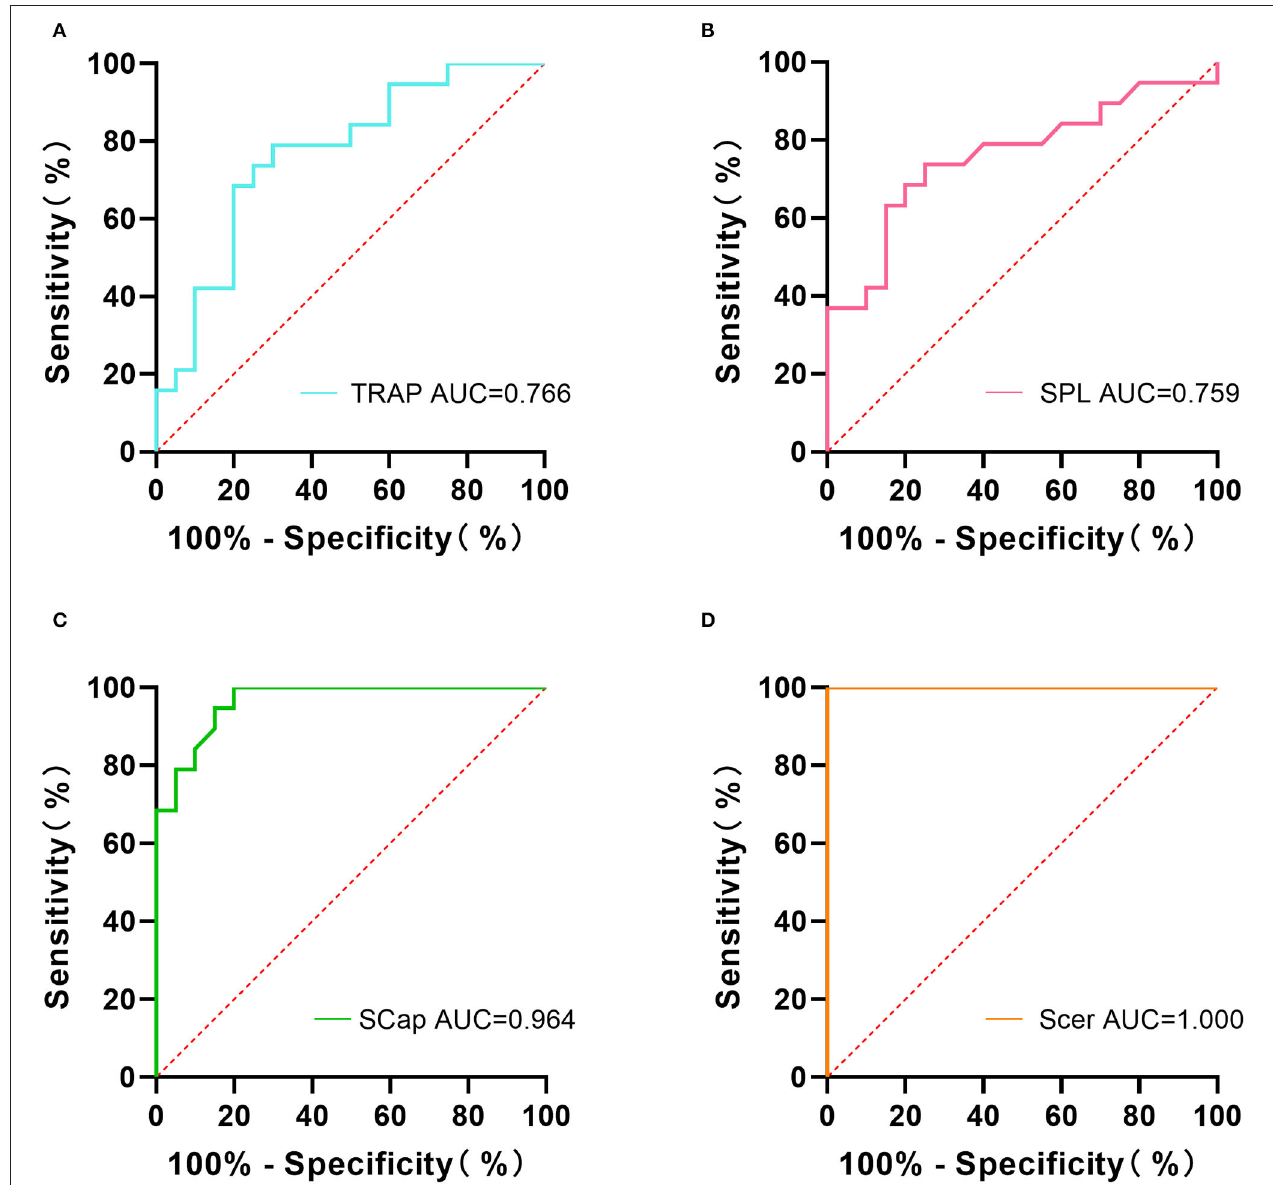
FIGURE 4 | Receiver operating characteristic (ROC) analysis of superficial cervical extensor muscle stiffness in diagnosing CEH. The AUC values of TRAP (A) , SPL (B) , SCap (C) , and SCer (D) were 0.766, 0.759, 0.964, and 1.000, respectively. AUC, area under the curve; TRAP, trapezius; SPL, splenius capitis; SCap, semispinalis capitis; SCer, semispinalis